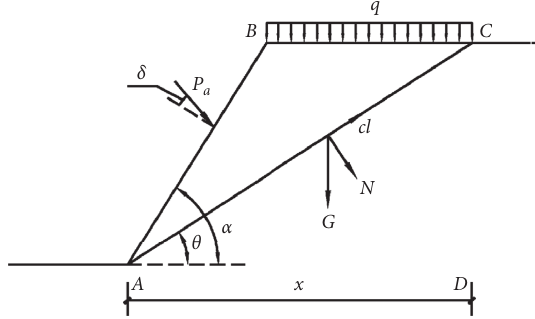
Figure 1: Earth pressure